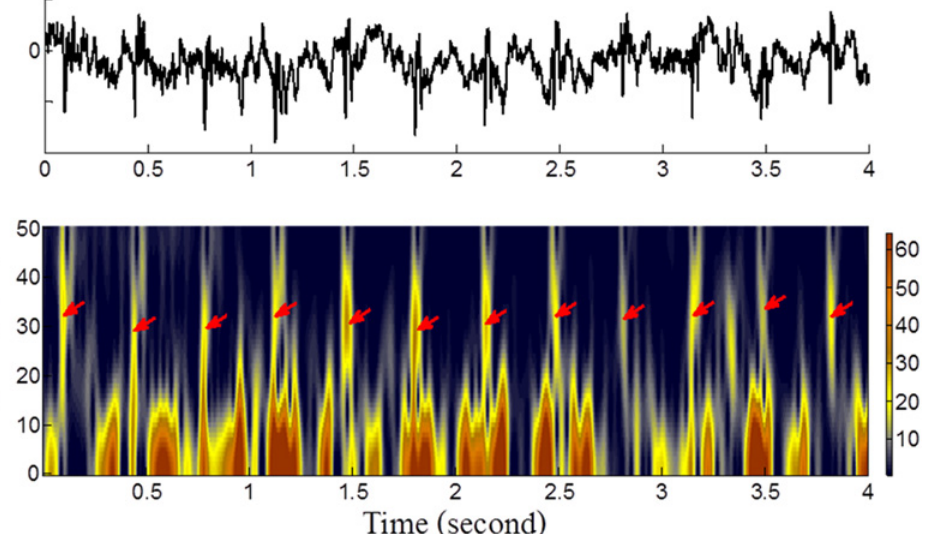
Fig 3. An example of Gabor time frequency representation (lower panel) of ECG signals with suppressed maternal ECG (upper panel). The red arrows indicate the location of the fetal QRS waves, which occupy a frequency range of ~10Hz to 20Hz intermittently that are free of material contamination in Gabor